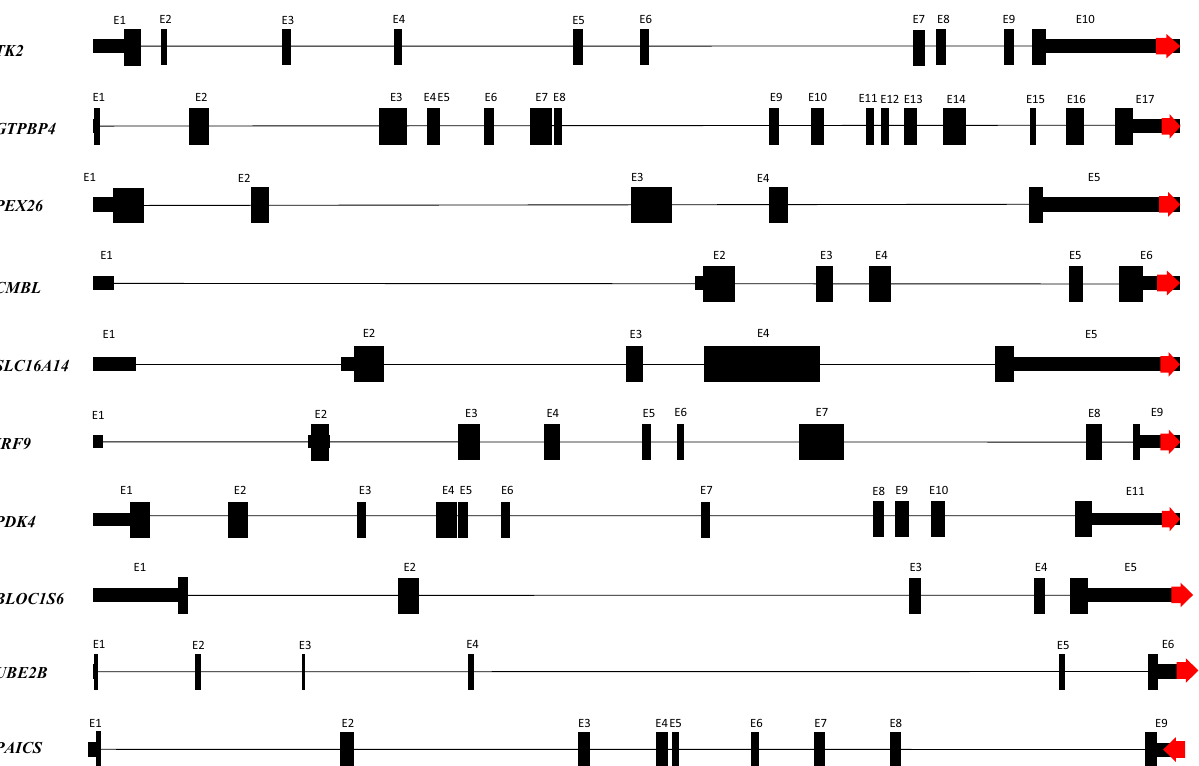
Figure 1. Identification of genes that had an Alu YRa1-derived 3 ′ UTR-end. Ten genes were identified. Red arrows indicate Alu YRa1. Vertically longer boxes and shorter boxes represent ORF and UTR, respectively. This illustration is not drawn to scale. ORF open reading frame. UTR untranslated